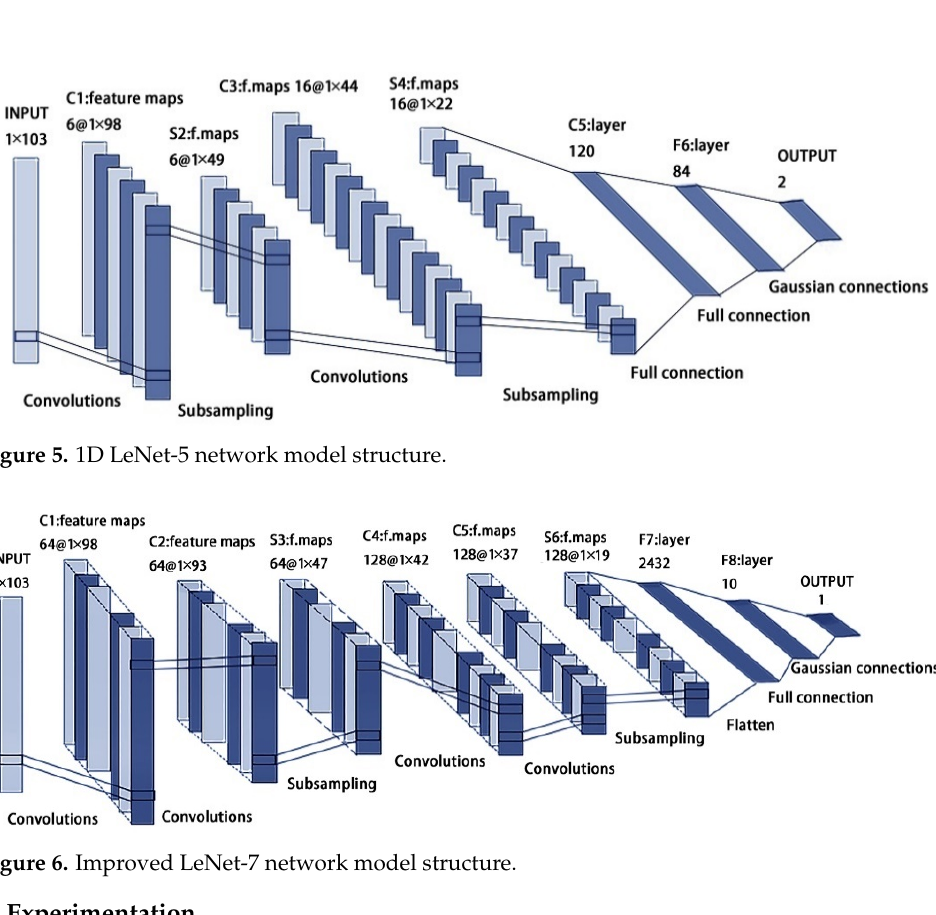
Figure 6. Improved LeNet-7 network model structure.